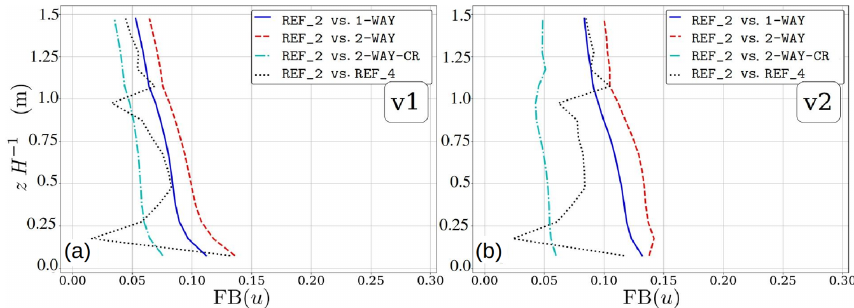
Figure 20. Fractional bias (FB) values evaluated over 15 x – y planes in the range 0 ≤ z/H ≤ 1 . 5, for (a) v1 and (b) v2. Table 3. Total number of grid points N gp , number of parallel processes N procs , required CPU and wall-clock times, and other performance measures for the hill and the cube array v1 test cases. Here N (cid:49)t is the number of time steps taken during the